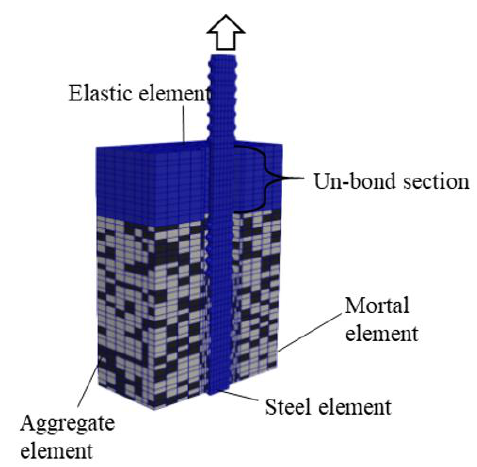
Figure 10. FE analysis model (half slice